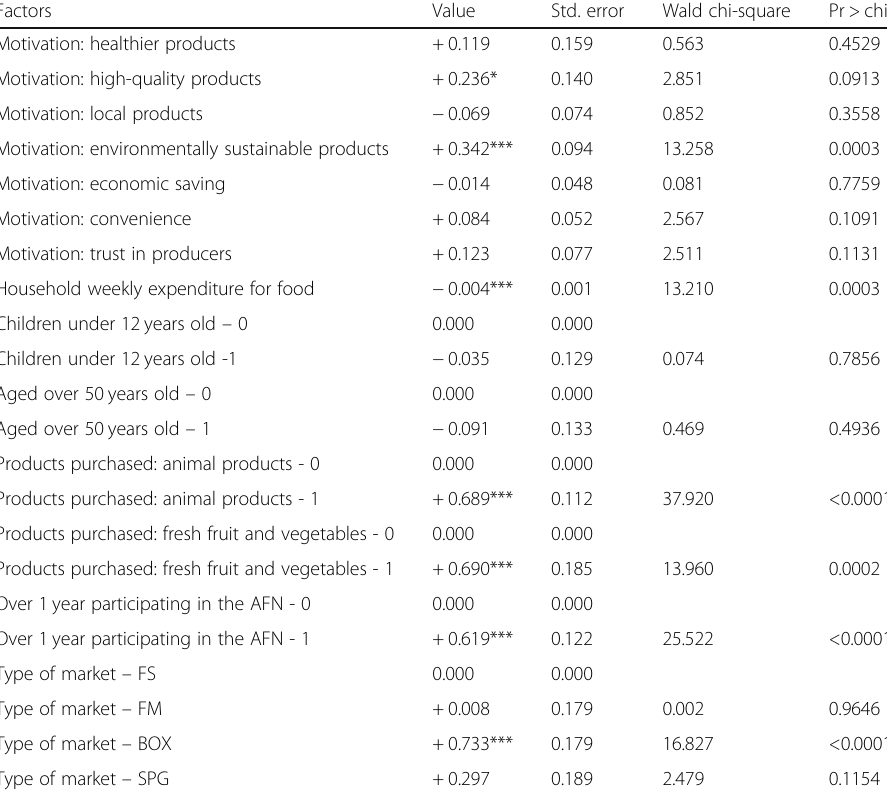
Factors Value Std. error Wald chi-square Pr > chi